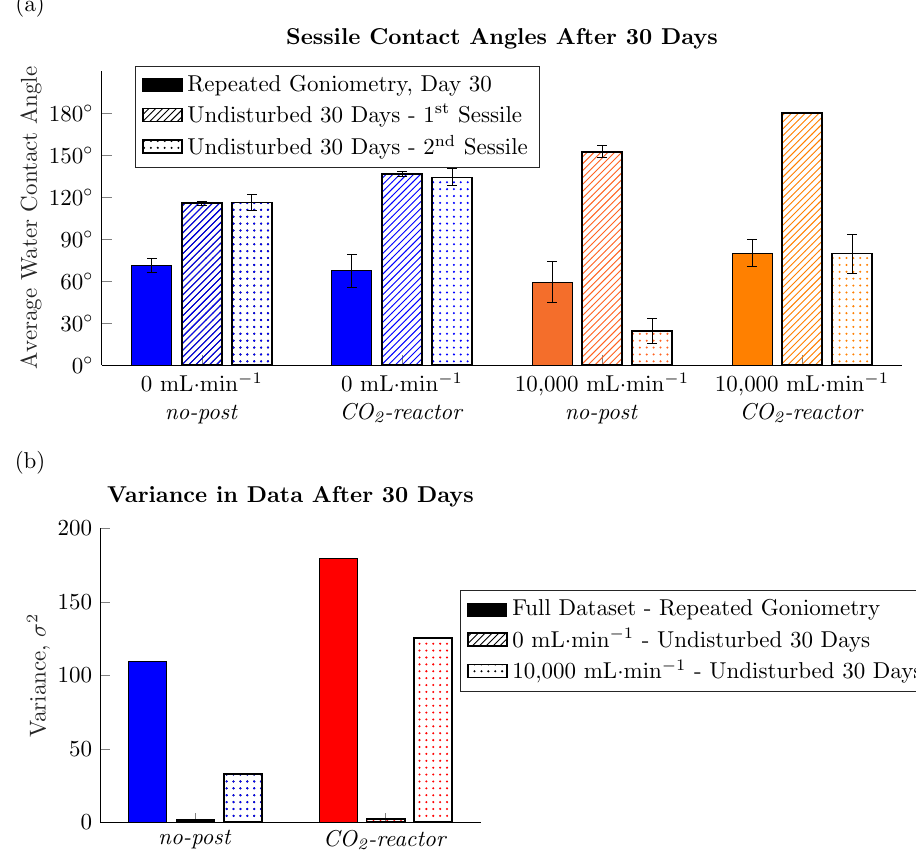
Figure 5. ( a ) Average sessile contact angle measured on no-post and CO 2 -reactor surfaces left undis- turbed for 30 days after fabrication before goniometric measurements were taken. ( b ) Variance in the sessile water contact angle data presented in part ( a